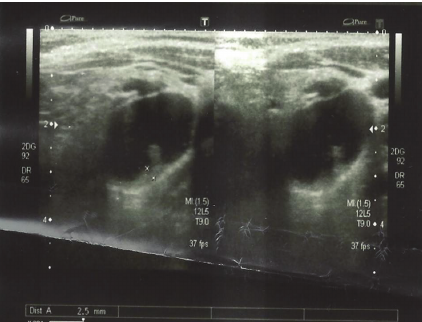
Figure 1: Ultrasonographic image of cystic lesion (17 × 26mm) in left lobe of thyroid gland.